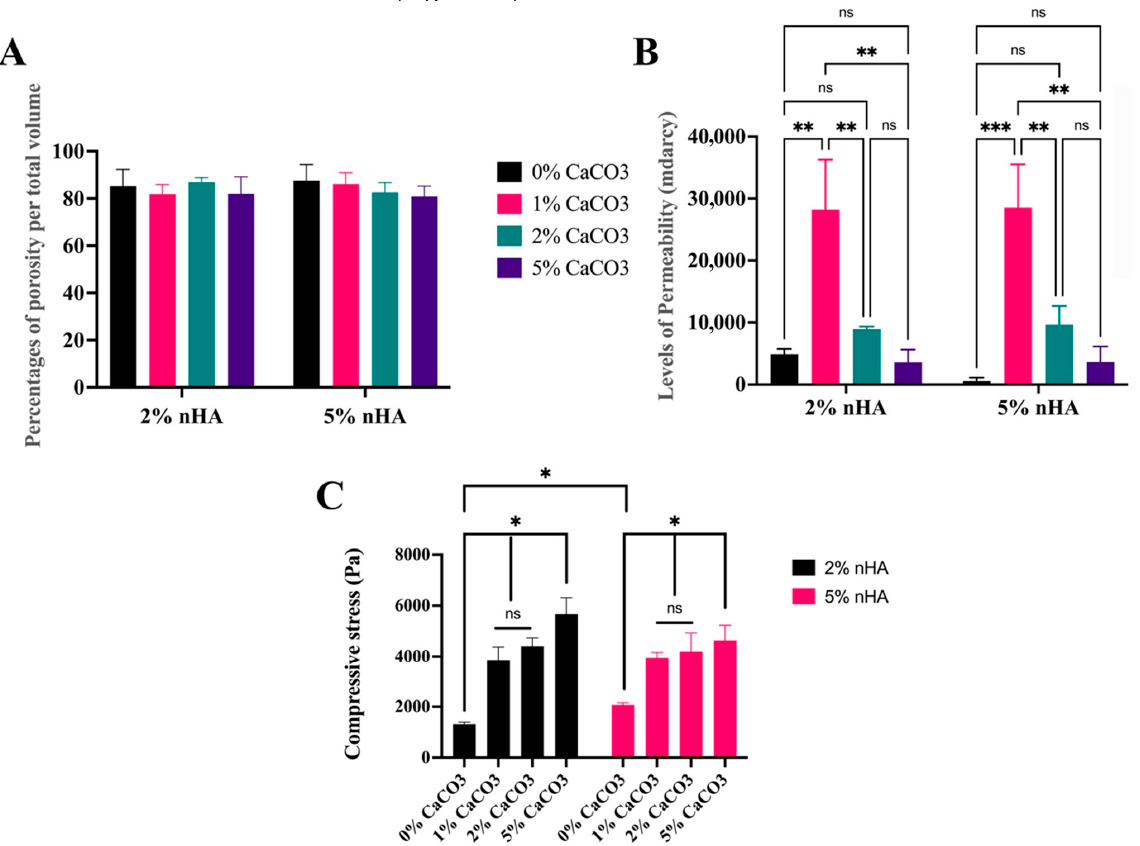
Figure 4. Mercury intrusion porosimetry (MIP) and compression tests demonstrating effects of calcium carbonate microcapsules on porous structures and mechanical strength of the thermosensitive 1%, 2%, and 5% calcium carbonate microcapsules–2% and 5% (w/v) nanohydroxyapatite–10% ( w / v ) β - glycerophosphate–4:1 ( w / w ) chitosan/collagen hydrogel (nHA–CaCO3–chitosan/collagen). MIP analysis on ( A ) percentages of total porosity and ( B ) permeability. ( C ) Compressive strength of the hydrogels. The abbreviation mdracy denotes millidarcy (1 Darcy is approximately 10 − 12 m 2 ), and ns denotes “not significantly different at p > 0.05”. Symbols *, **, and *** represent significantly different values with p < 0.05, p < 0.01, and p < 0.001, respectively (n = 5, mean ± SD).